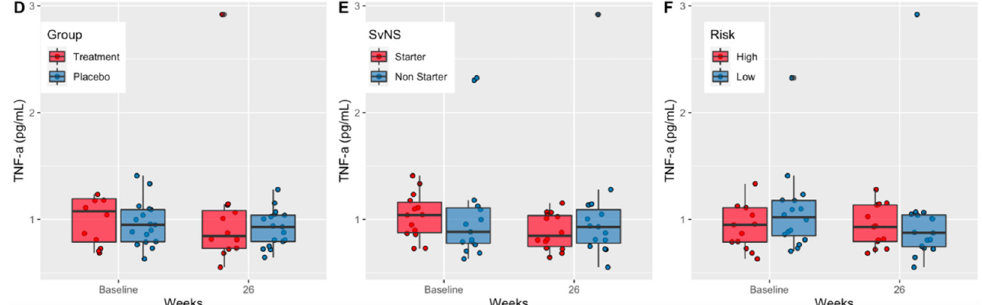
Figure 5. Serum IL-6 and TNF-a concentrations by treatment group, starter status, and risk. ( A ) Serum IL-6 concentrations (pg/mL) in the treatment and placebo groups at baseline, mid-season (week 17), and at end of treatment (week 26). ( B ) Serum IL-6 concentrations (pg/mL) in starters and non-starters at baseline, mid-season (week 17), and at end of treatment (week 26). ( C ) Serum IL-6 concentrations (pg/mL) in high- and low-risk position groups at baseline, mid-season (week 17), and at end of treatment (week 26). ( D ) Serum TNF-a concentrations (pg/mL) in the treatment and placebo groups at baseline, mid-season (week 17), and at end of treatment (week 26). ( E ) Serum TNF-a concentrations (pg/mL) in starters and non-starters at baseline, mid-season (week 17), and at end of treatment (week 26). ( F ) Serum TNF-a concentrations (pg/mL) in high- and low-risk position groups at baseline, mid-season (week 17), and at end of treatment (week 26). IL-6, interleukin-6; TNF-a, tumor necrosis factor-alpha; p -values show significance within groups from baseline values (+) according to repeated measures ANOVA and estimated marginal means; p -values + p < 0.05; ++ p < 0.01, +++ p < 0.001 and ++++ p < 0.001.